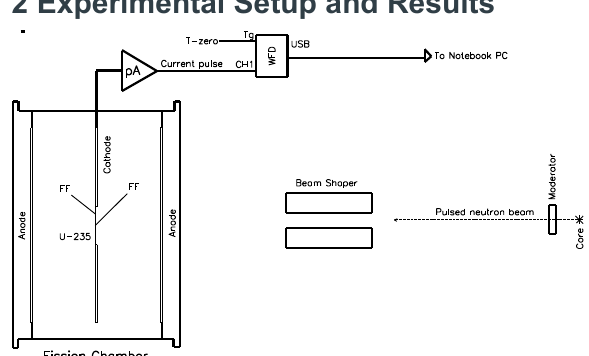
Fig. 1 . Fission chamber with associated preamplifier, WFD and beam shaping